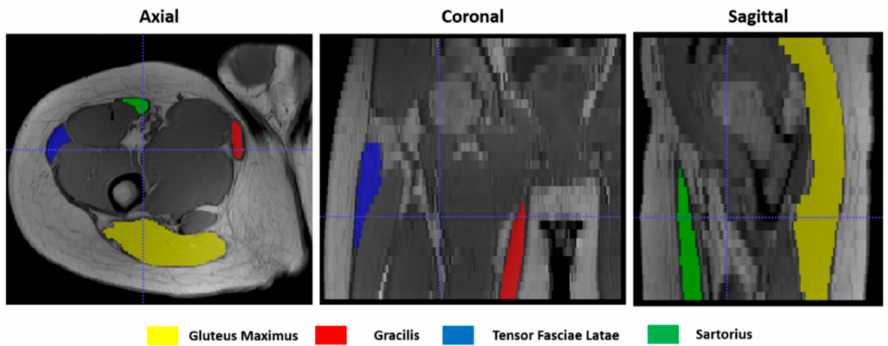
Figure 4. Muscle ROIs delineation on T1-w MR images in 3 orthogonal